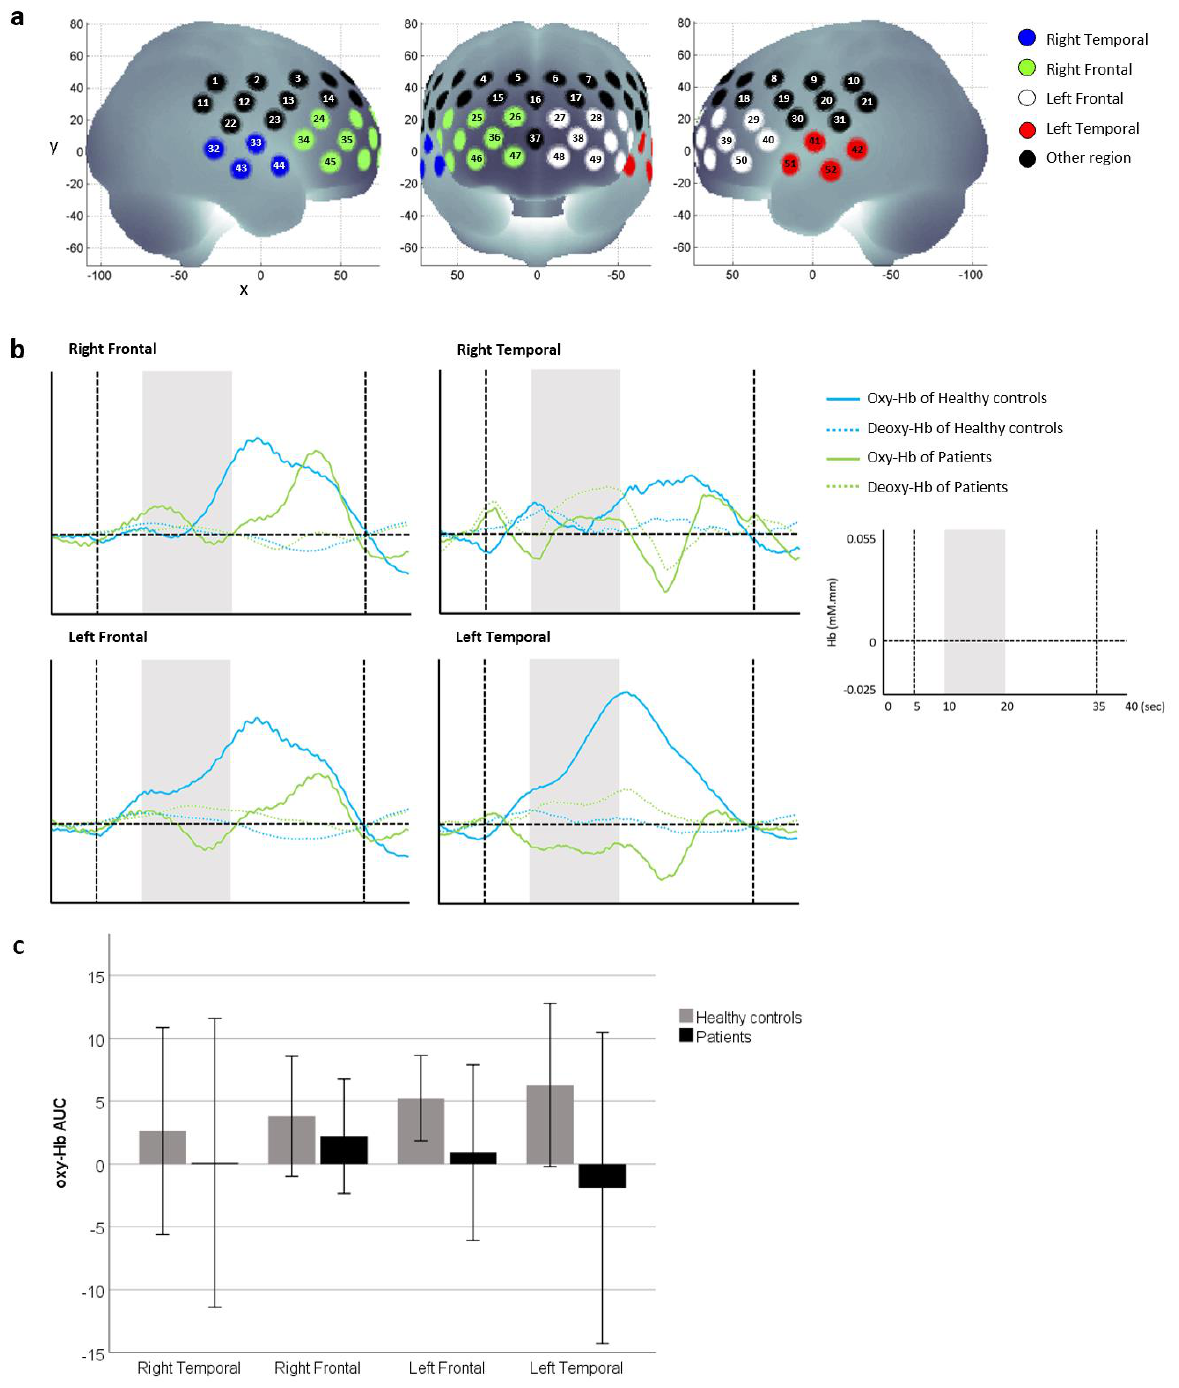
Figure 1. ( a ) Four regions called the right and left frontal and temporal regions were studied. ( b ) Average oxy-hemoglobin and deoxy-hemoglobin waveforms of patients who recovered from COVID-19 infection and healthy controls who never contracted COVID-19 were generated for each region. Grey areas indicate the olfactory stimulus period, and vertical dotted lines indicate the time period used to calculate the AUC of oxy-hemoglobin. ( c ) Comparison of oxy-hemoglobin AUC between healthy controls and patients. Data are presented as mean ± SD. There were no differences between groups when oxy-hemoglobin AUC at each region were compared using Mann–Whitney U tests ( p > 0.05).